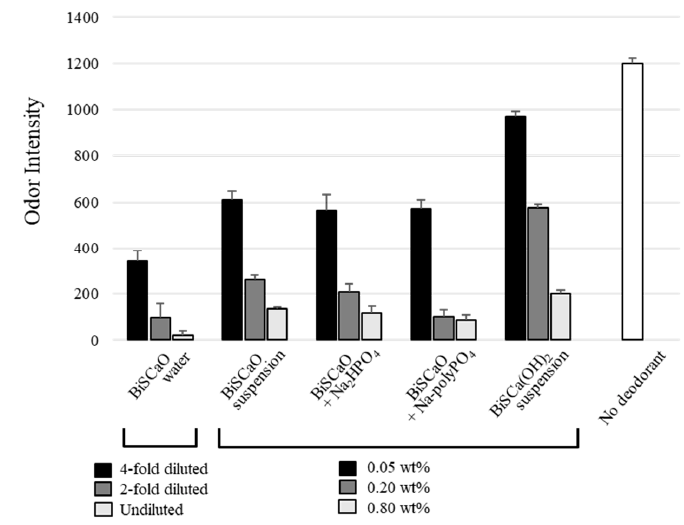
Figure 2. Efficacies of BiSCaO water, suspension, dispersion, and colloidal dispersions